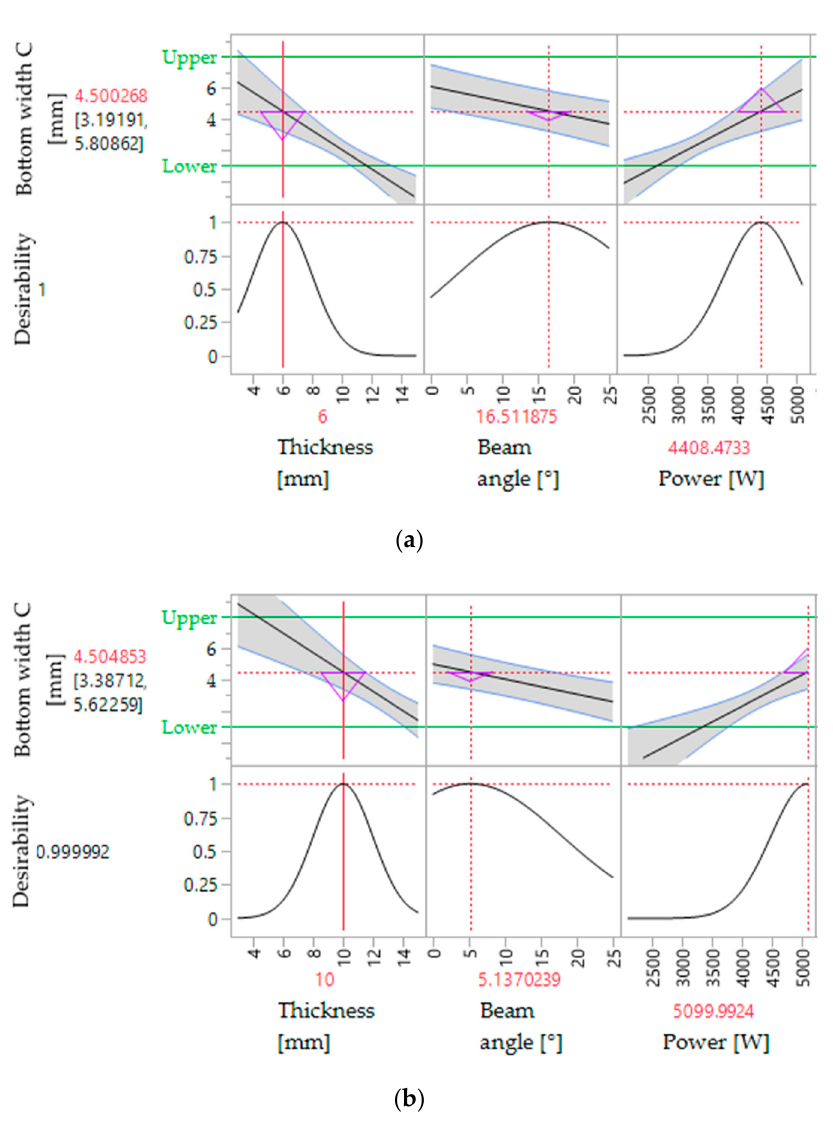
Figure 12. Profiles of the response surface for optimizing bottom width C (penetration) for two different thickness values: ( a ) 6 mm thickness; ( b ) 10 mm thickness. Image taken from JMP ® prediction profile.